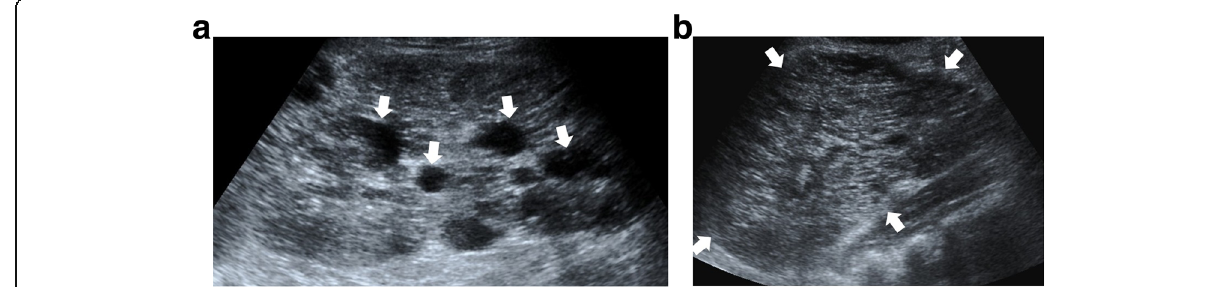
Fig. 16 A 3-year-old male patient known ARPKD. a Sagittal view US image shows an enlarged kidney with cortical and medullary hyperechogenicity due to small cysts. There are also bigger cysts in the kidney (arrows). b Axial plane US image of the liver shows contour